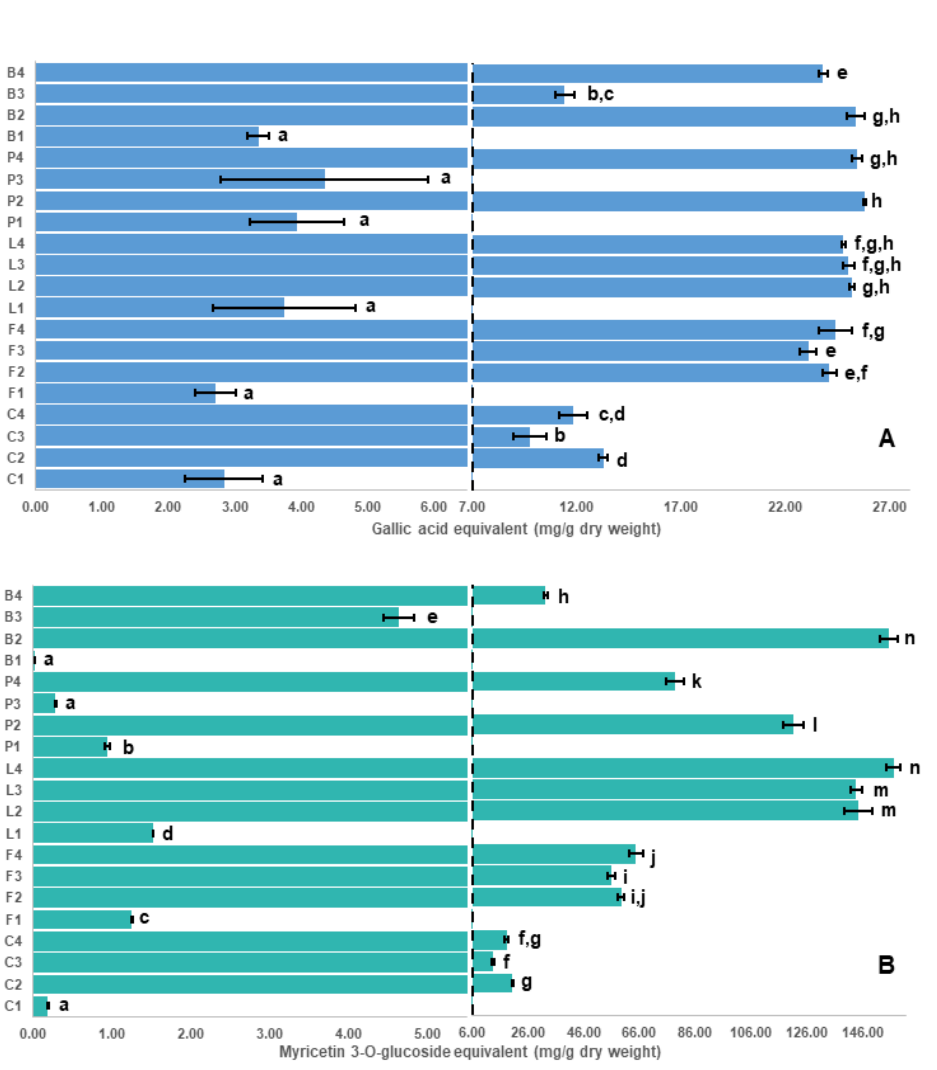
Figure 2. Antioxidant capacity of different genotypes of pulse seed coats measured F-C ( A ) and FRAP ( B ) assays. Letters on y-axis refer to different pulse crops; C: chickpea, F: faba bean, L: lentil, P: pea and B: common bean, whereas numbers refer to different seed coat colors. For example, L2 refers to black seed coats of Indianhead lentil (see Table 3 for codes). F-C: Folin–Ciocalteu assay; FRAP: Ferric reducing antioxidant power. Bars with different letters for each assay are significantly different ( p < 0.05).